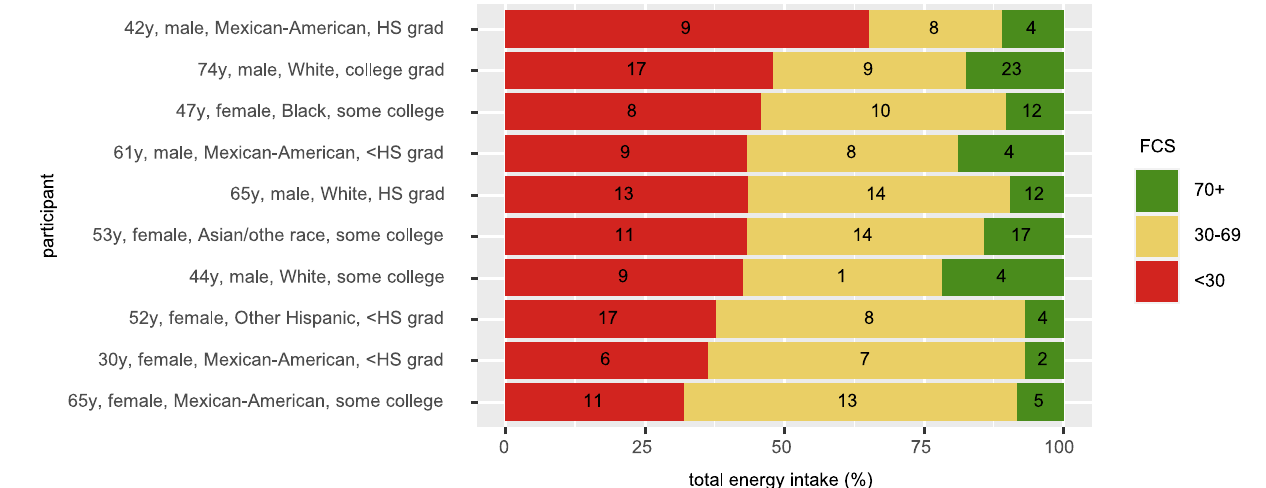
Fig. 2 | Examples of individuals having the mean U.S. i.FCS of 35.5, demon- strating variation in the consumption of products with FCS ≤ 30, 31 – 69, and ≥ 70 that achieves a similar overall score. The distribution (count and contribu- tiontototalenergyintake[%])ofconsumedfoodandbeverageproducts,basedon previously de fi ned product healthfulness thresholds (i.e., FCS ≤ 30 as products to minimize; FCS 31-69 as products to be consumed in moderation; and FCS ≥ 70 as products to be encouraged) was assessed for all NHANES participants. Examples